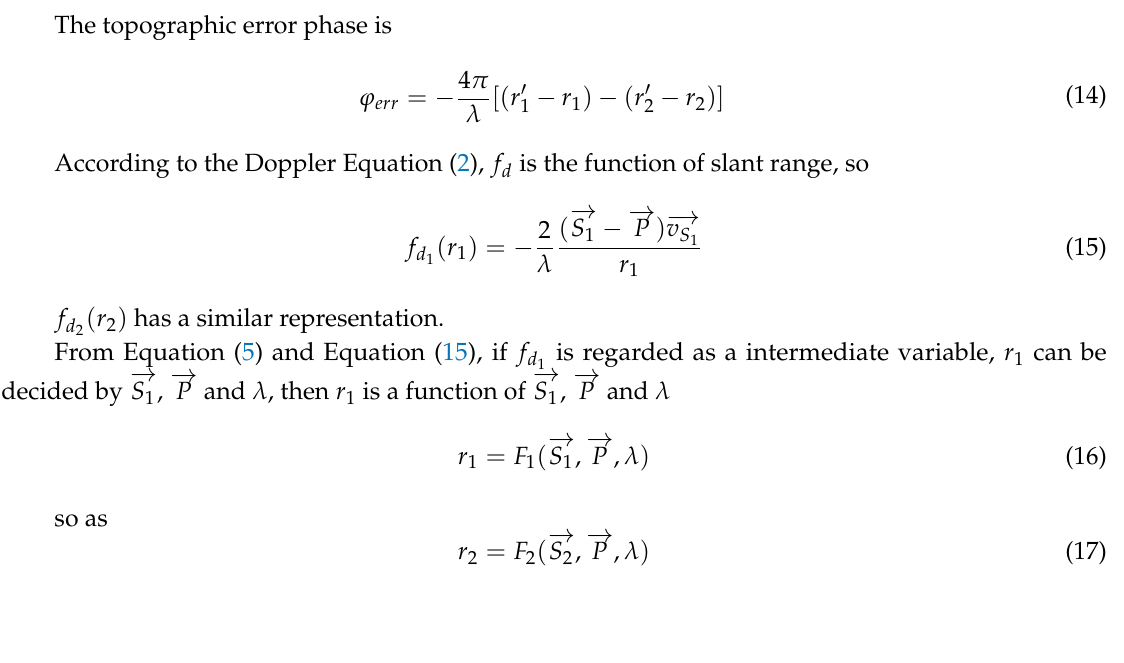
Figure 2. The geometric model of repeat-pass interferometric synthetic aperture radar